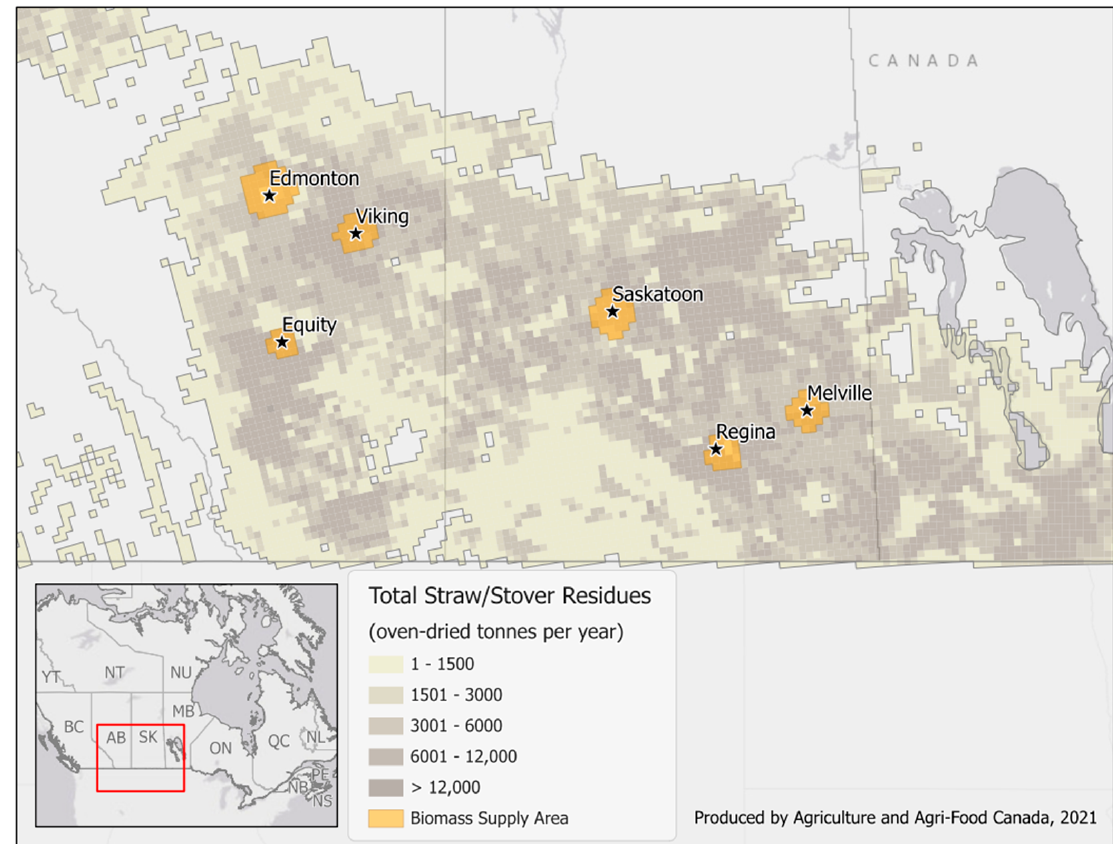
Figure 6. Locations of six potential ag-pellet production sites and their biomass supply area, shown in yellow. These locations are selected based on the availability of commercial quantities of ag-